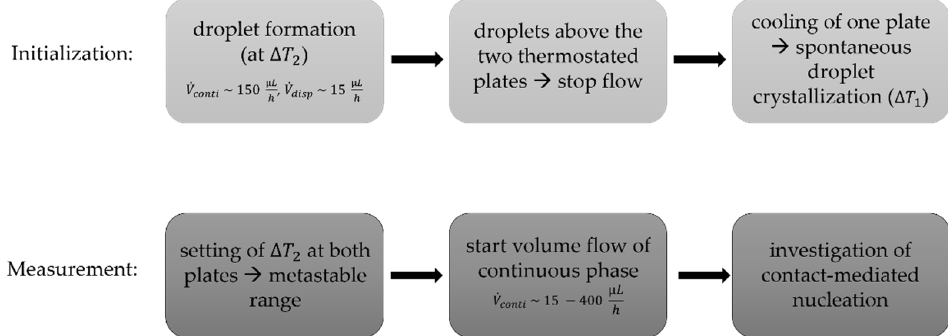
Figure 4. Experimental protocol for microfluidic experiments designed to investigate CMN.